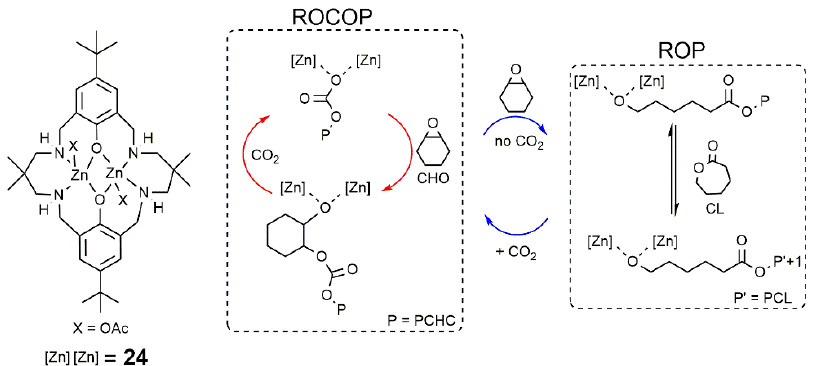
Scheme 5. The switch catalysis mechanism, ROCOP and ROP promoted by 24 . Reproduced with modification and permission from ref [46]. Copyright (2014) John Wiley and Sons.